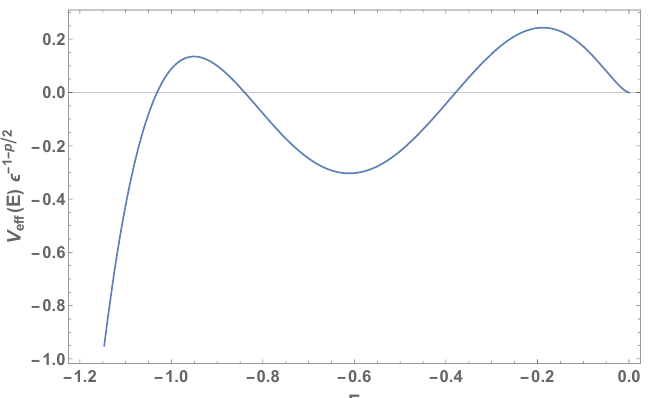
Figure 1 . A plot of V eff ( E ) ε − 1 − p 2 in equation (3.27) for the case p = 7 . We have set t = 1 . In general there are p − 1